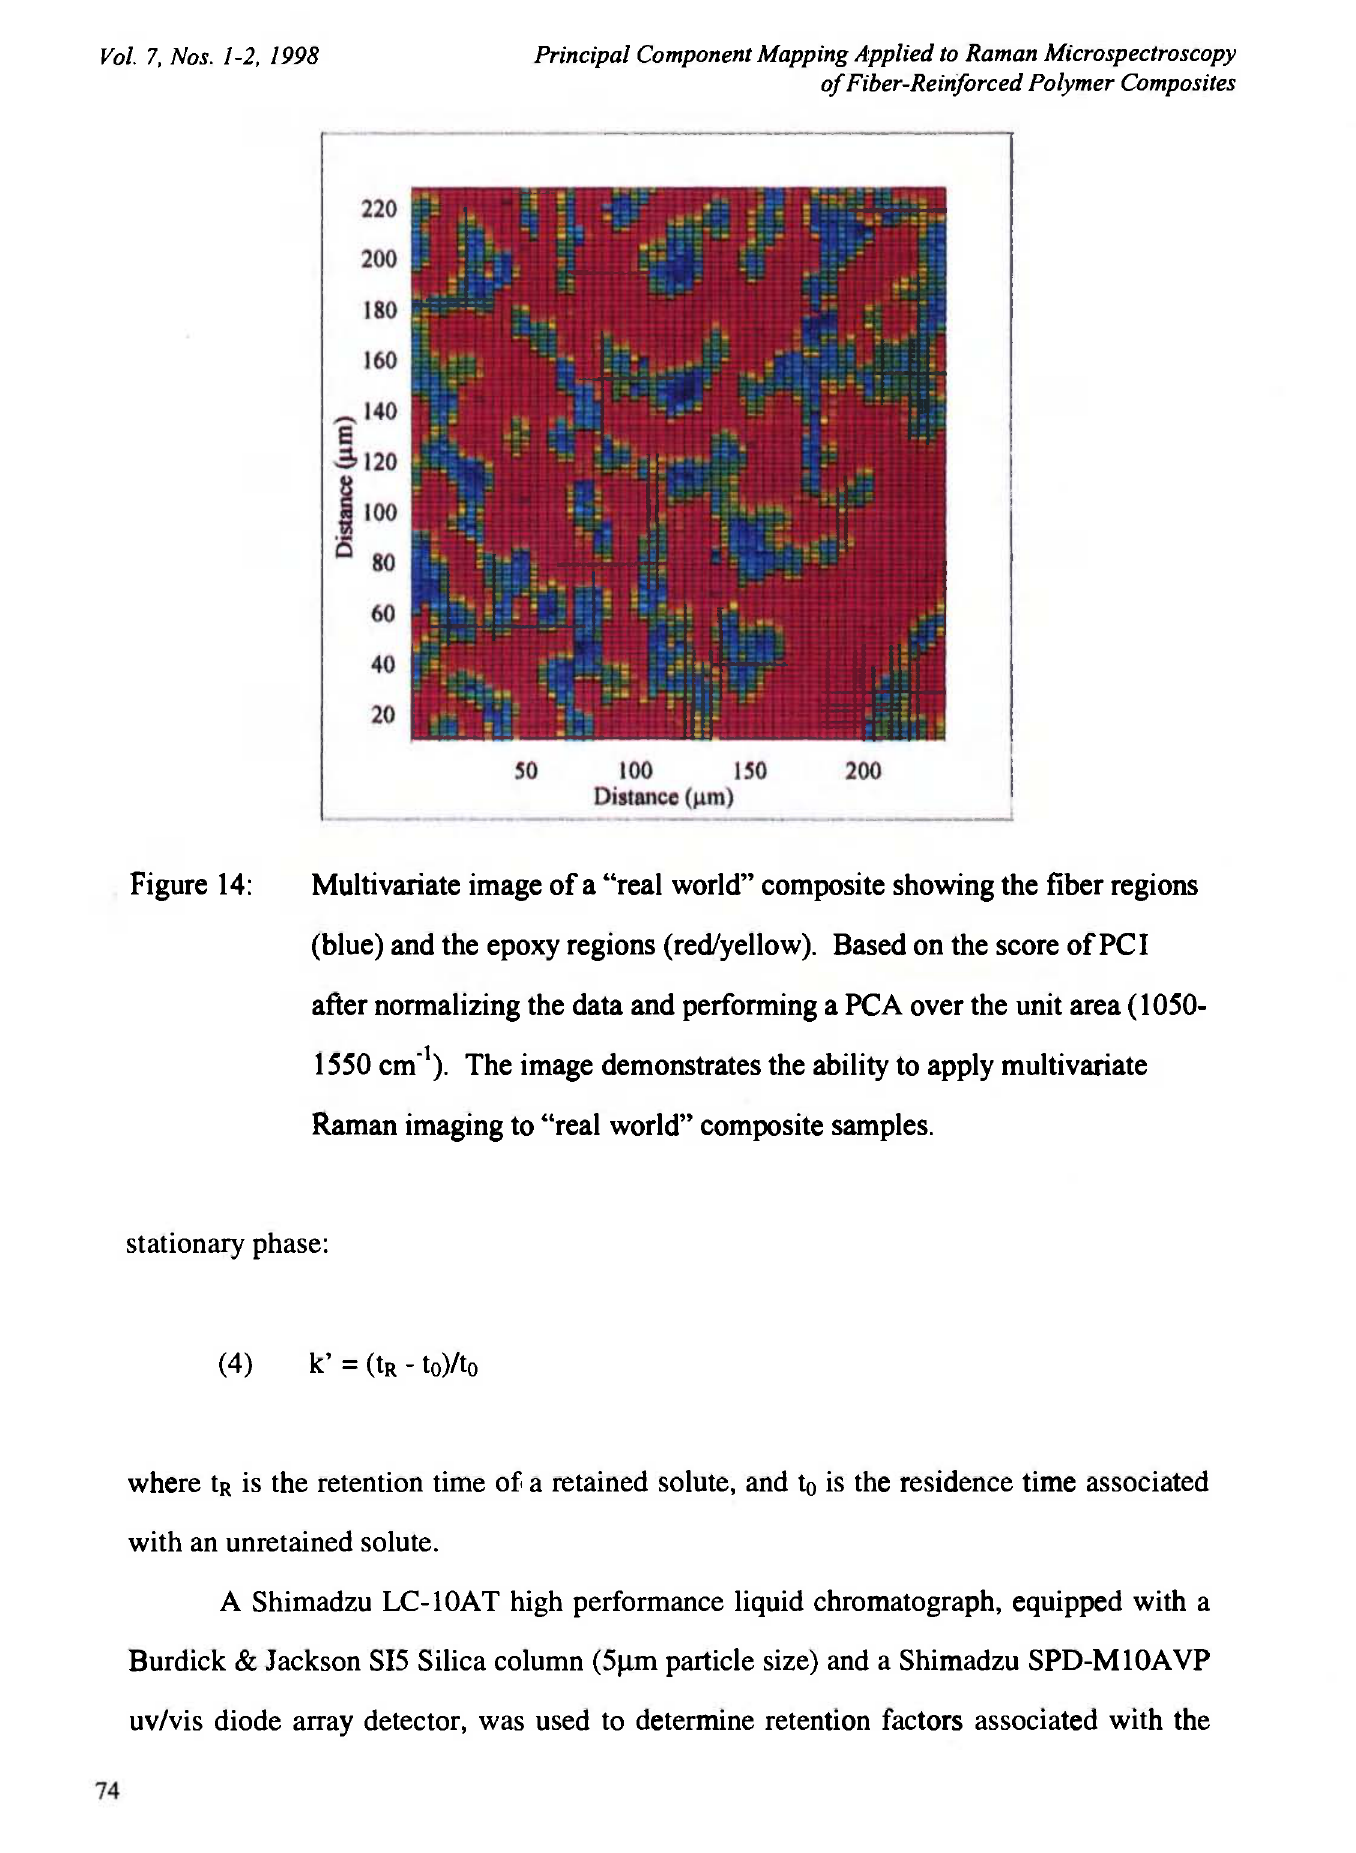
Figure 14: Multivariate image of a "real world" composite showing the fiber regions (blue) and the epoxy regions (red/yellow). Based on the score of PCI after normalizing the data and performing a PC A over the unit area (1050- 1550 cm" 1 ). The image demonstrates the ability to apply multivariate Raman imaging to "real world" composite